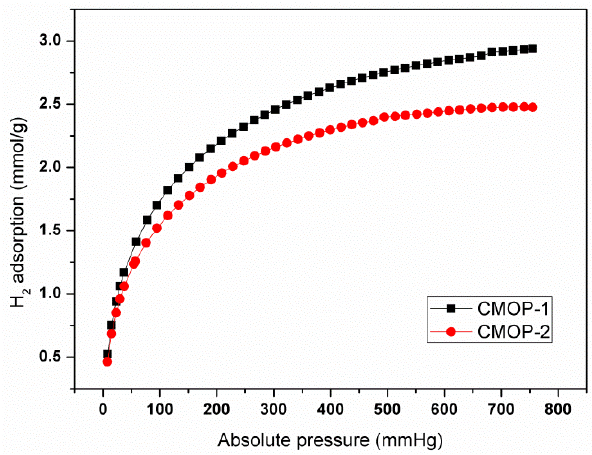
Figure 3. H 2 adsorption isotherm at 77 K.